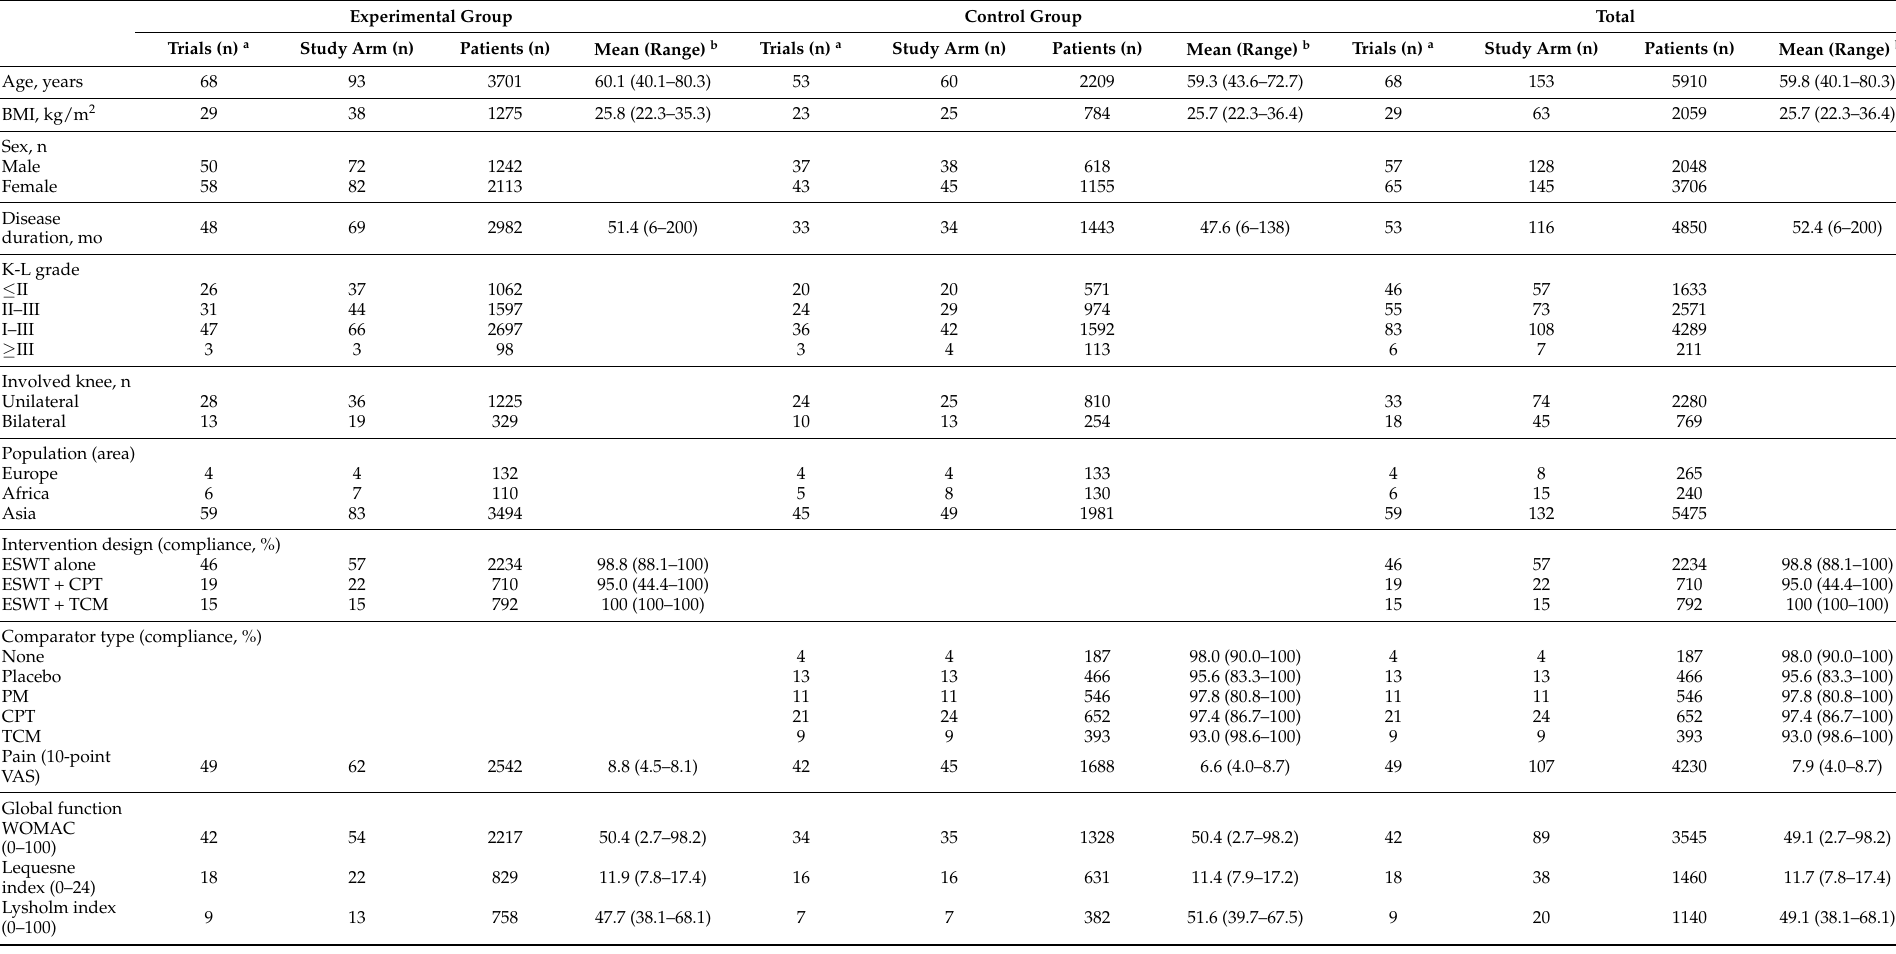
Table 2. Summary of study